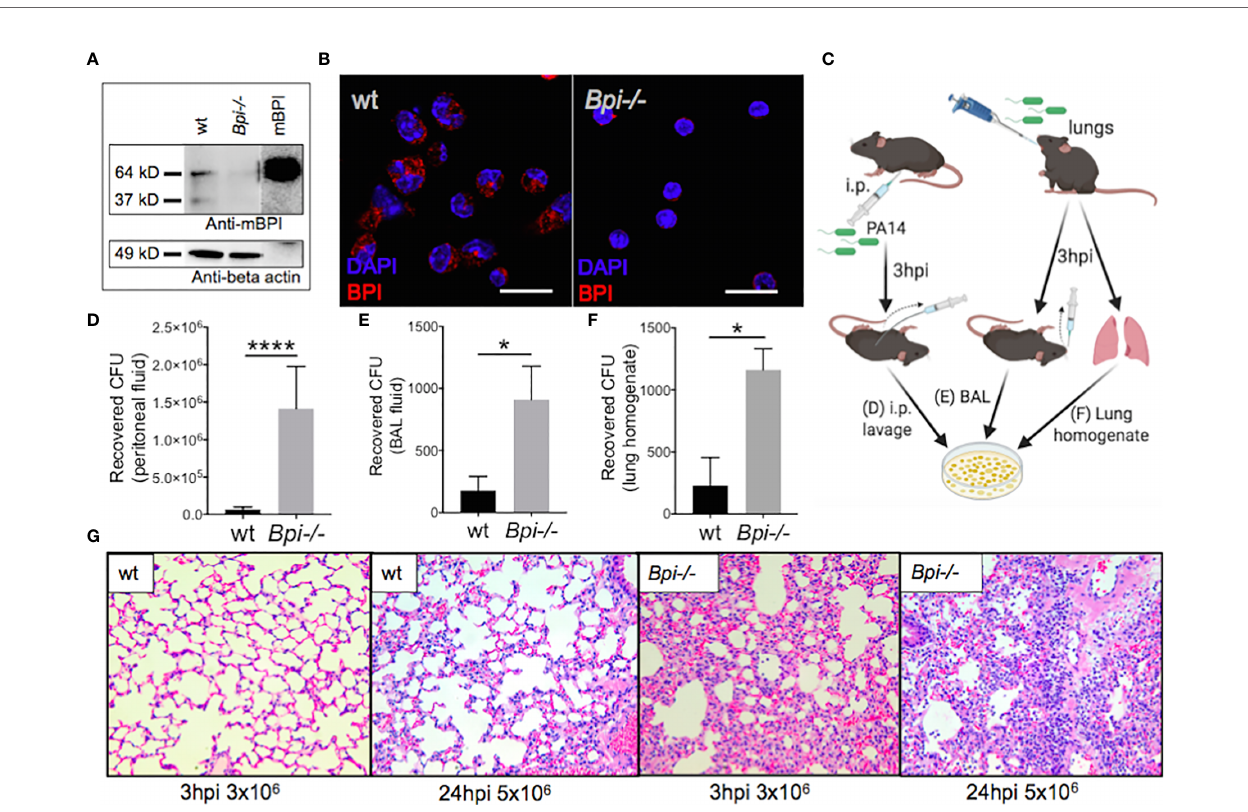
FIGURE 1 | BPI is required for ef fi cient P. aeruginosa clearance and control of lung in fl ammation in vivo . (A) Immunoblots of anti-mouse BPI (mBPI) (amino acids 256-269) and anti-beta actin antibody reactivity to neutrophil lysates (20 m g) from wild type (wt) and BPI-de fi cient ( Bpi -/-) mice. Recombinant mBPI (0.5 m g) used as control. (B) Immuno fl uorescence staining of BPI (red) and DAPI (blue) in the peritoneal wt and Bpi-/- mouse PMNs (mPMNs). Images obtained using a 63X oil immersion objective. Scale bar: 20 m m. (C) Mice were infected with 3x10 6 CFU PA14 via intraperitoneal or oropharyngeal route before lavages or lung homogenate were obtained 3hpi to plate for colony count. (D) Colony forming units (CFU) recovered from peritoneal fl uid of mice (n=5) infected with P. aeruginosa PA14 (3x10 6 CFU) 3 hrs post-infection (hpi). (E) CFU recovered from bronchoalveolar lavage (BAL) of mice (n=4) infected with PA14 (3x10 6 CFU) 3 hpi. (F) CFU recovered from whole lung homogenates of mice (n=3) infected with PA14 (3x10 6 CFU) 3hpi. (G) Lung histology of wt and Bpi-/- mice infected via oropharyngeal route with PA14 (3x10 6 , 3hpi or 5x10 6 , 24hpi). Representative H&E staining shown at 40x magni fi cation. Images shown are representative for three samples for each genotype. Statistical signi fi cance was determined by Unpaired t-test with Welch ’ s correction, ****p < 0.0001, *p < 0.05, ns, not signi fi cant; Error bars represent mean ±